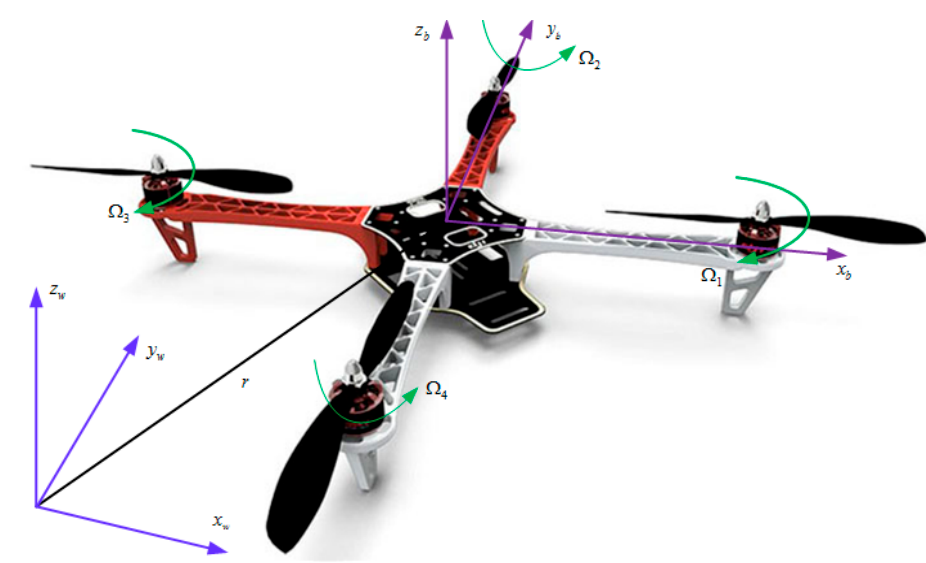
Figure 1. The structure of quadrotor and its coordinate system.